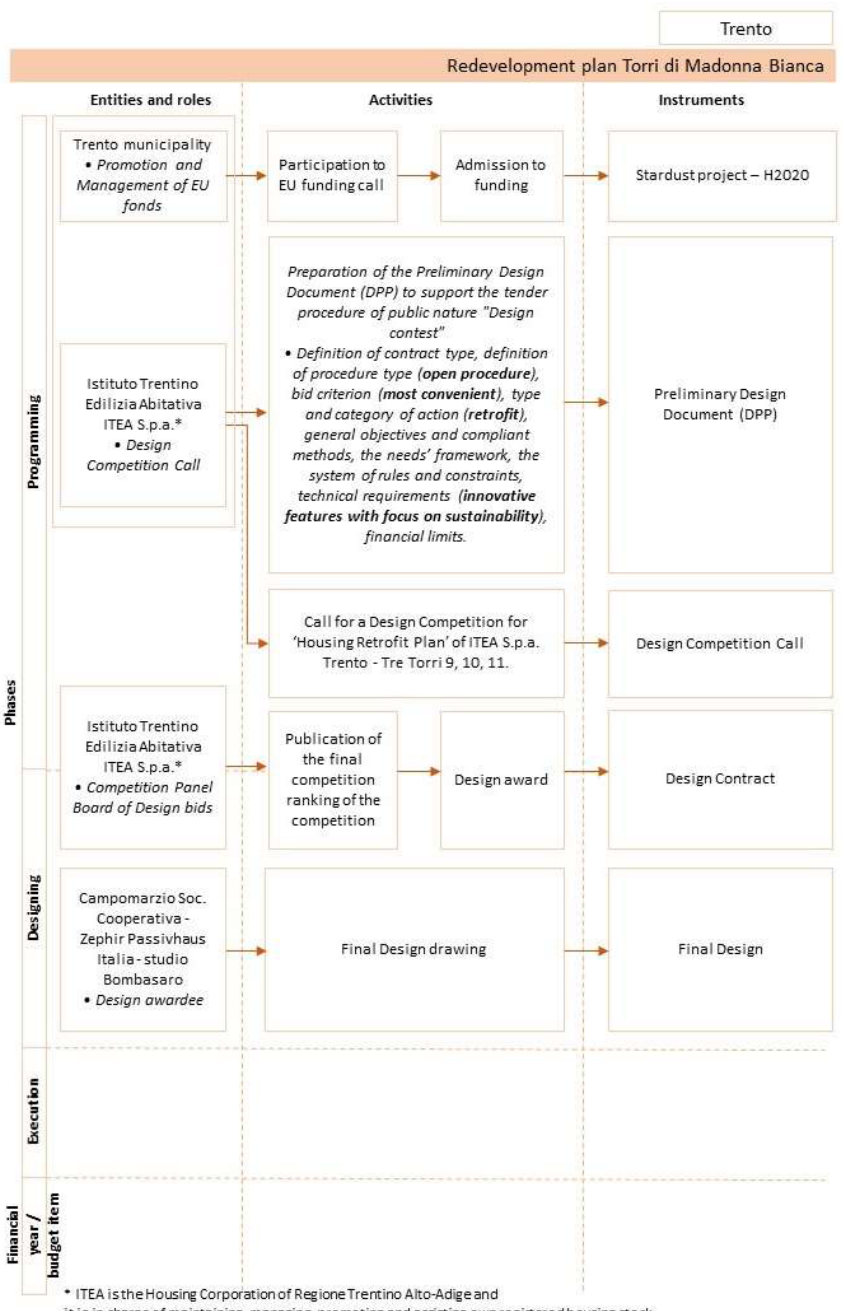
Figure 8. Trento case study project intervention: the implementation processes.